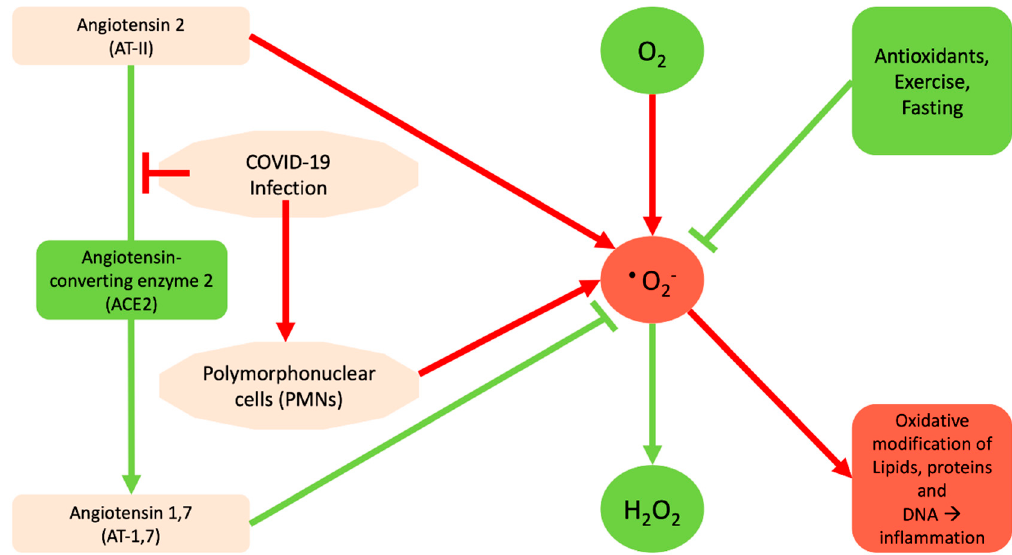
Figure 2. Diagram indicating how COVID-19 may contribute to the generation of free radicals. The red arrow and red shapes indicate processes as well as the contributions of COVID-19 to the generation of reactive oxygen species (ROS). The negative impact of ROS on the macromolecules and on subsequent inflammatory processes is shown. Green arrows / line and green shapes indicate processes and / or enzymes that eliminate ROS or prevent its generation.